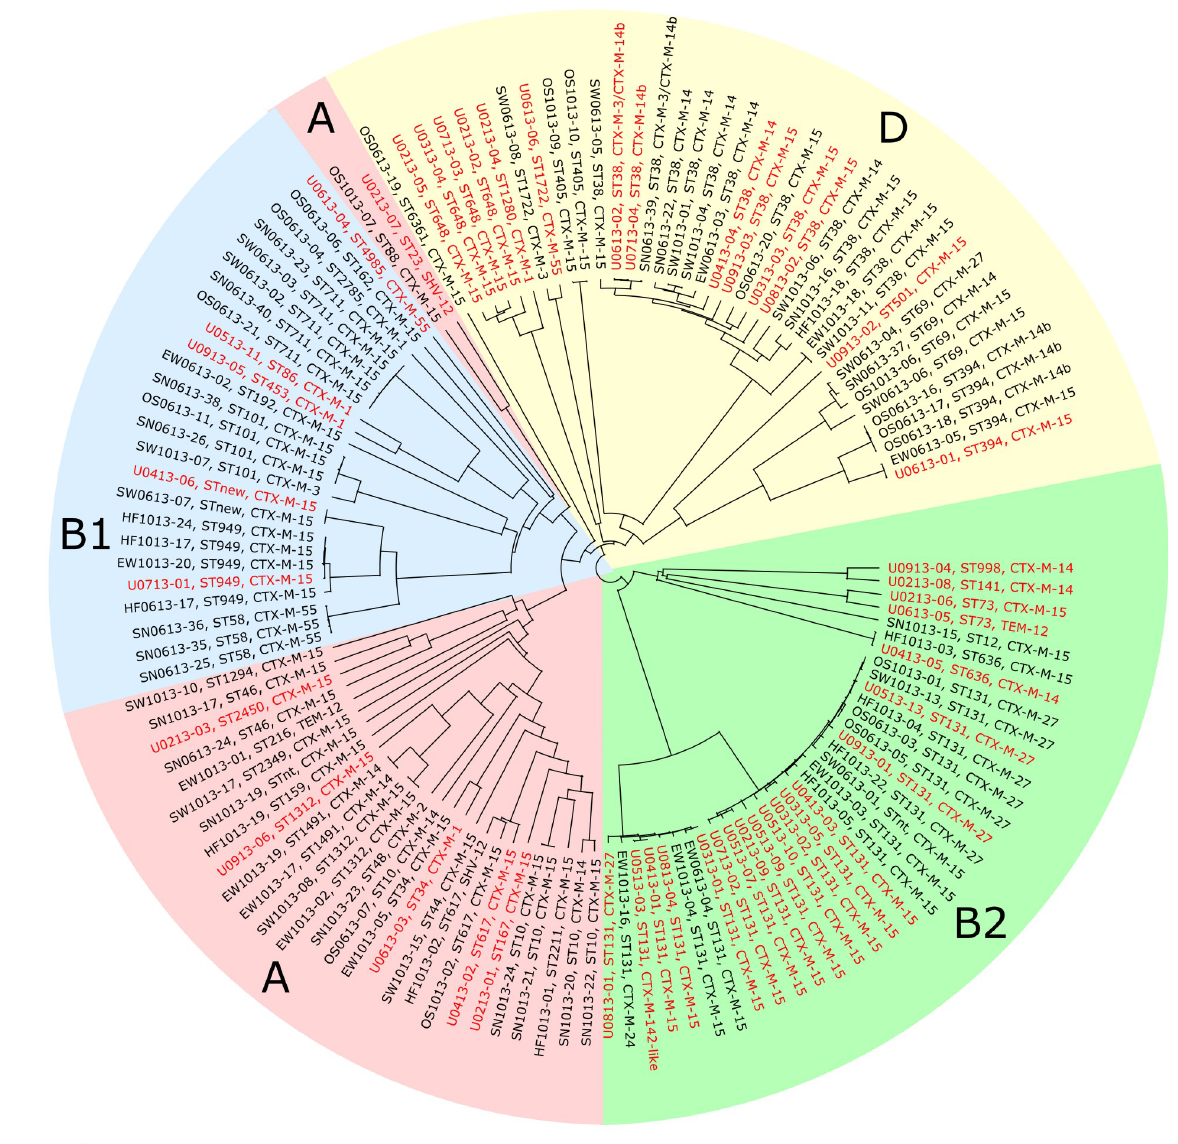
Fig 2. Neighbor–joining (NJ) tree based on core genome multi–locus sequence typing (cgMLST) analysis. The NJ tree is based on allele differences in 1957 core genes found in 126 ESBL–producing E . coli isolates included in the cgMLST analysis. Isolate ID, ST, and ESBL type are written in red for the clinical isolates (n = 45), and in black for the environmental isolates (n = 81). The colored areas represent the different phylogenetic groups.